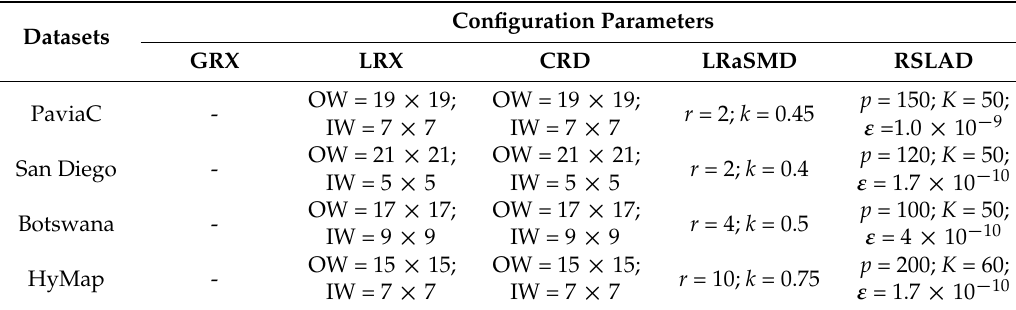
Table 1. The lists of parameters of all detectors on the four